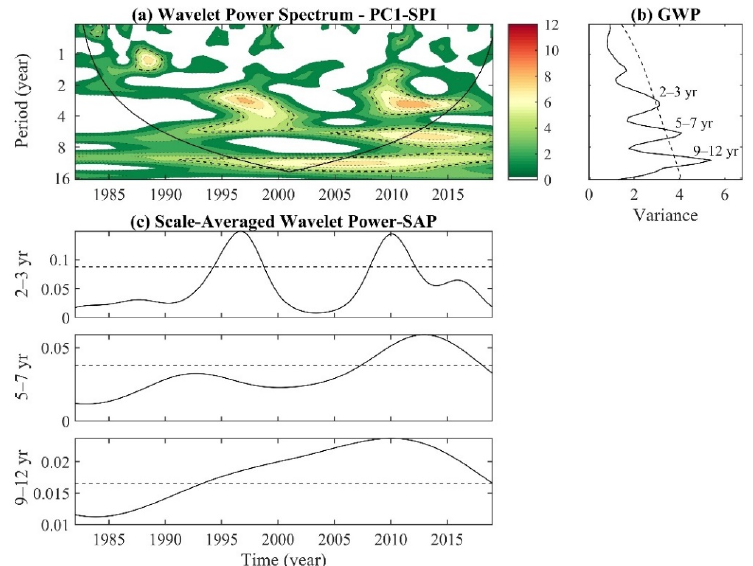
Figure 4. ( a ) Local wavelet power spectrum (WPS) of the continuous wavelet transform (CWT) concerning PC1 of the monthly SPI in the Sogamoso River Basin (SRB); ( b ) global wavelet power (GWP) using variance units; and ( c ) scale-averaged wavelet power (SAP) time series for the 2–3-, 5–7- and 9–12-year scales. The region where edge effects are significant is under the U-shaped curve in ( a ). The dashed line indicates the significant value at the 95% confidence level.